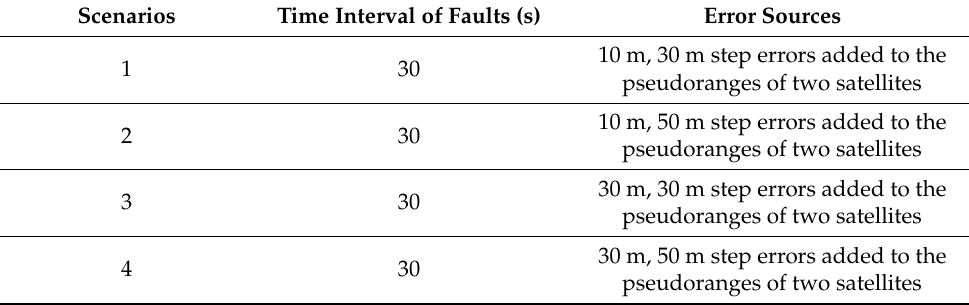
Table 2. The defined scenarios.